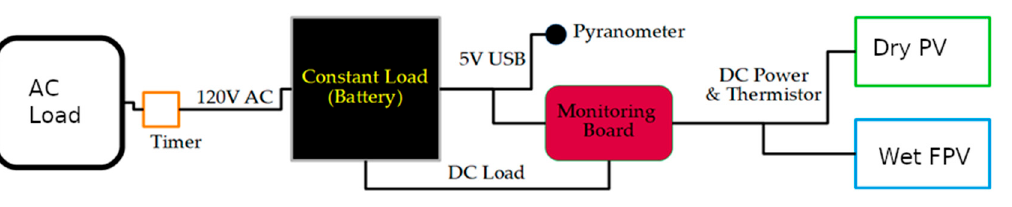
Figure 3. Wiring diagram for NanoDAQ monitoring board.